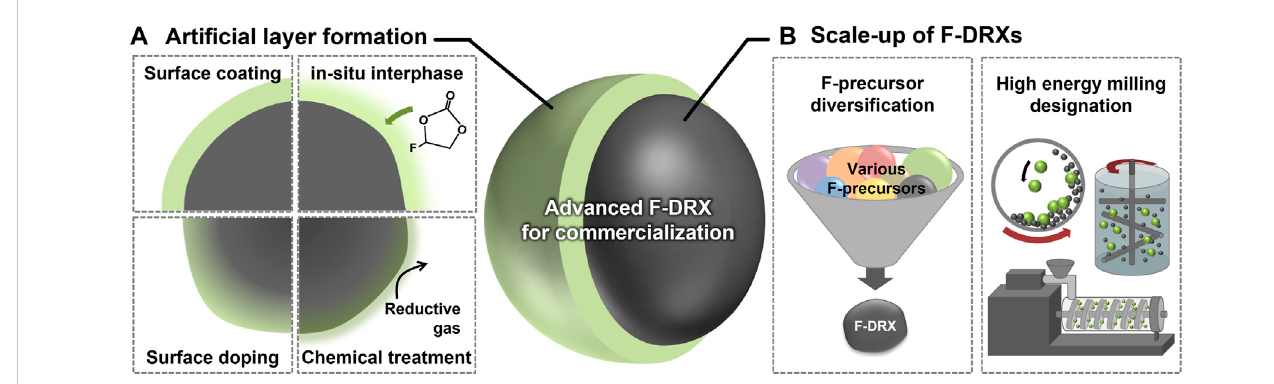
FIGURE 2 A schematic diagram suggesting the future research direction of fl uorinated cation-disordered rock-salts (F-DRXs) to enable commercialization. (A) Methodologies for arti fi cial interphase formation on the surface. (B) Requirements for the scale-up of F-DRXs including F-precursor diversi fi cation and designation of large-scale high-energy